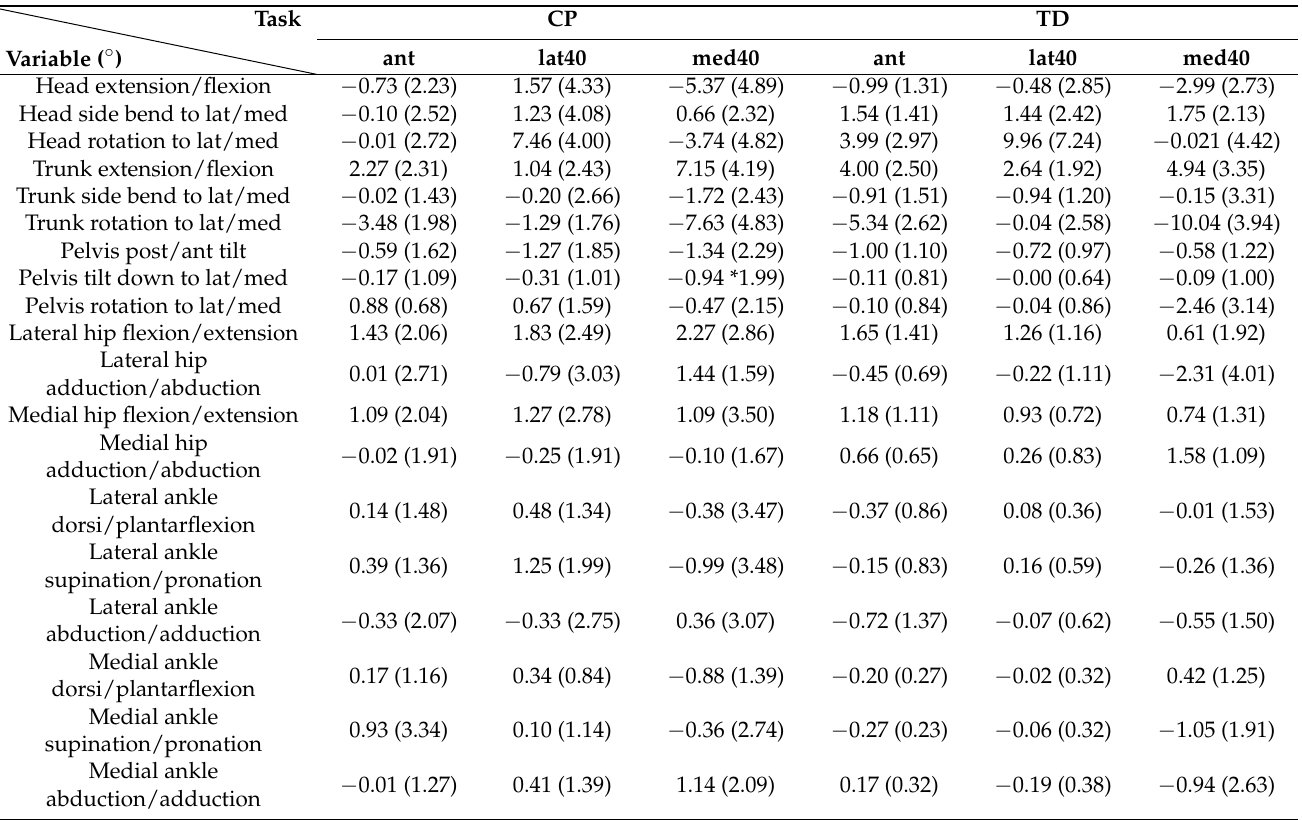
Table 2. Mean and standard deviation of dependent variables of angular changes in axial and lower extremity components during the hand acceleration